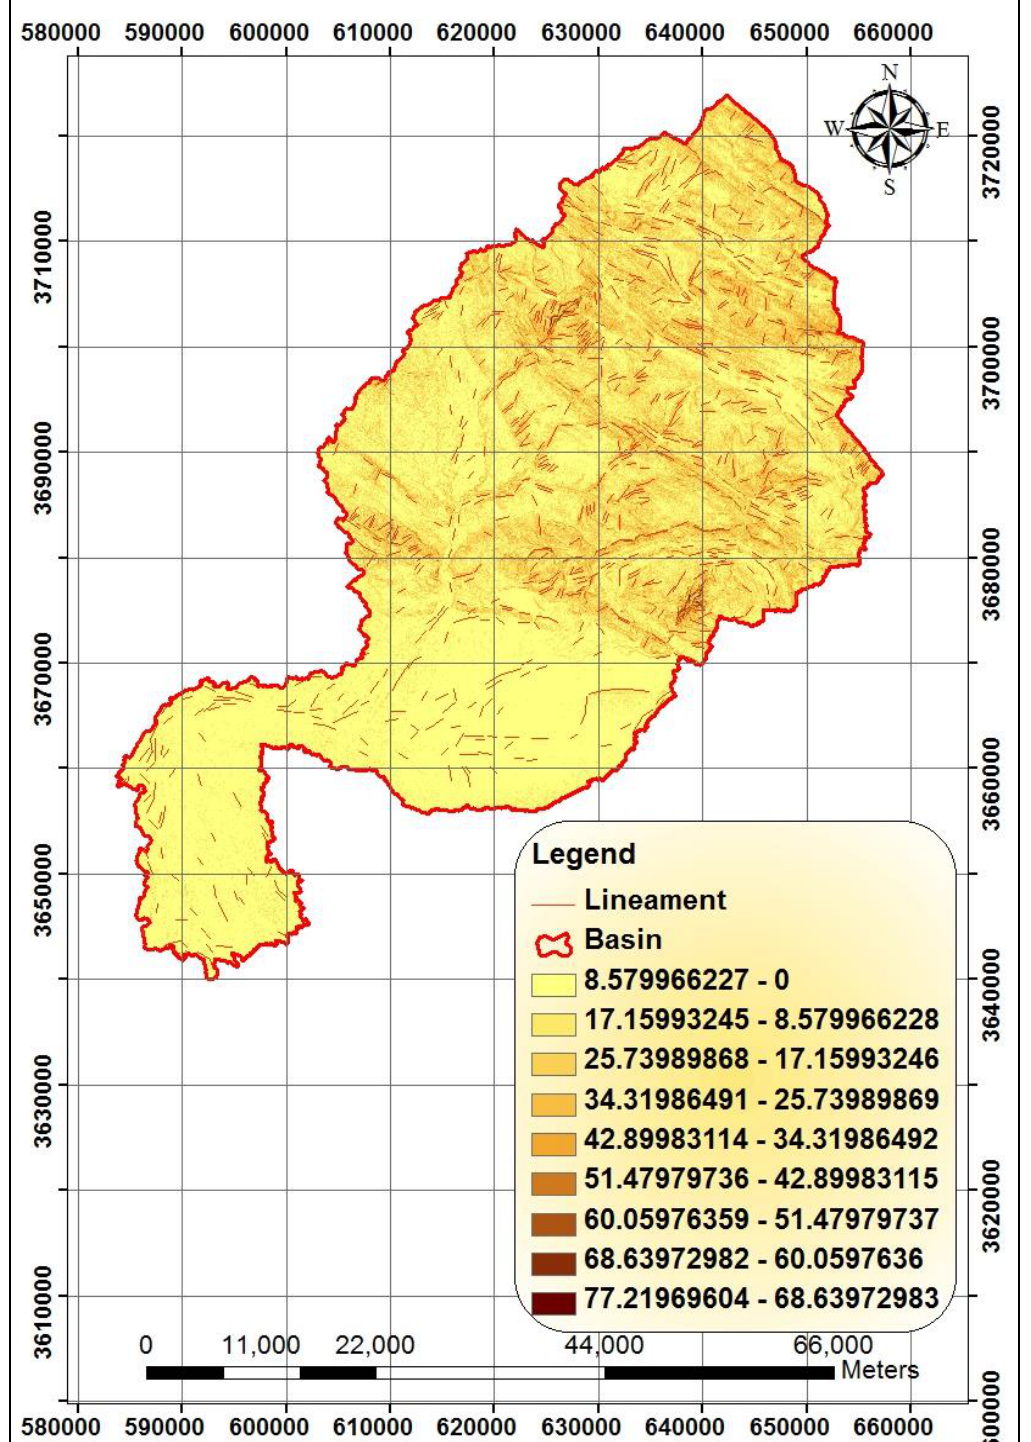
Fig.10: Map of relationship between the lineament density and slope